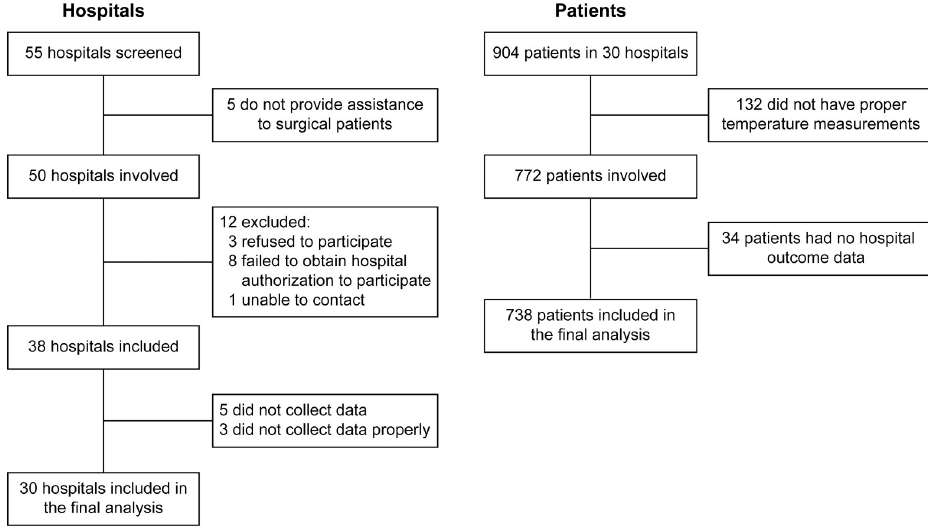
Fig 1. Flow chart of the study hospitals and